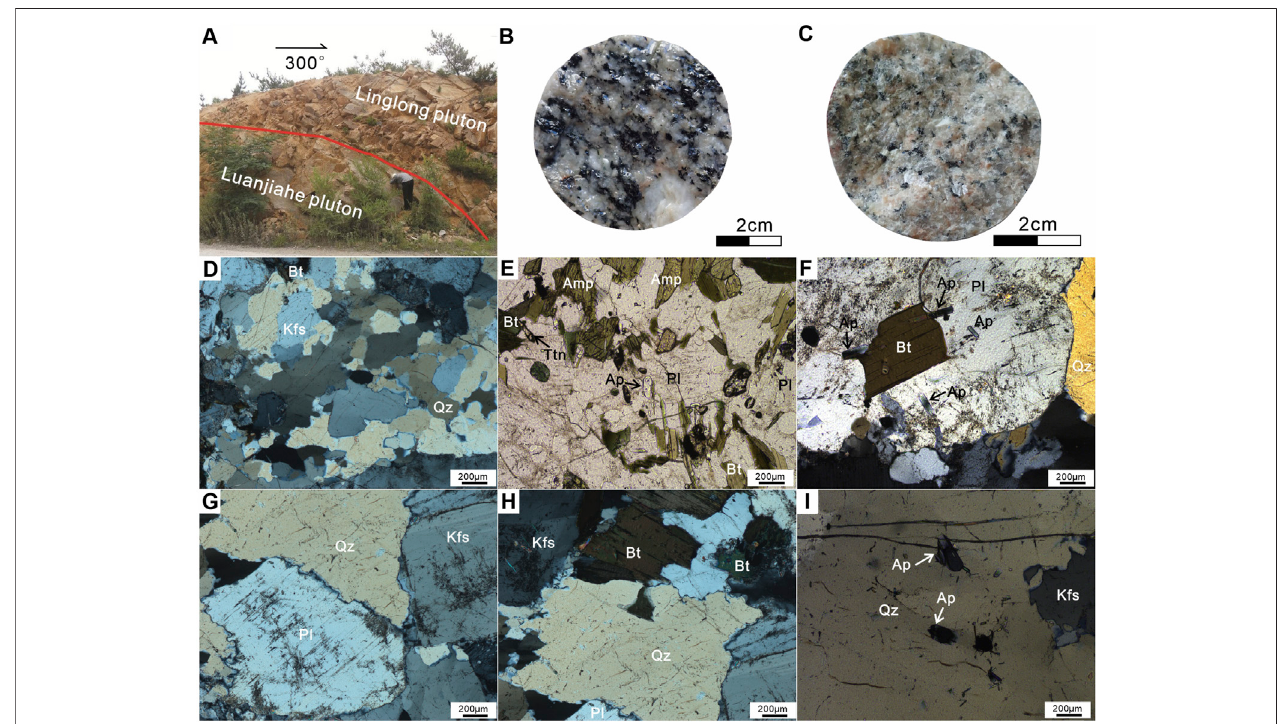
FIGURE2| Fieldphotograph (A) ,hand-specimenphotographs (B,C) ,andthin-sectionmicrophotographsoftheLinglong (D – F) andLuanjiahe (G – I) granitesinthe Jiaobei Terrane (A) The intrusive contact between Linglong pluton and Luanjiahe pluton, from Ren (2017) (B) Hand-specimen of Linglong fi ne-grained biotite granite (C) Hand-specimen of Luanjiahe medium-to coarse-grained granite (D) Quartz, K-feldspar, plagioclase, and biotite assemblages of Linglong granite (E) Amphibole, biotite, andtitaniteoccurrenceintheLinglonggranite (F) Apatitescontainedbyplagioclase (G,H) Intergrowncoarsequartz,K-feldspar,plagioclase,andbiotite (I) Apatites as inclusions in quartz. Abbreviations: Amp – amphibole; Ap – apatite; Bt – biotite; Kfs – K-feldspar; Pl – plagioclase; Qz – quartz; Ttn –